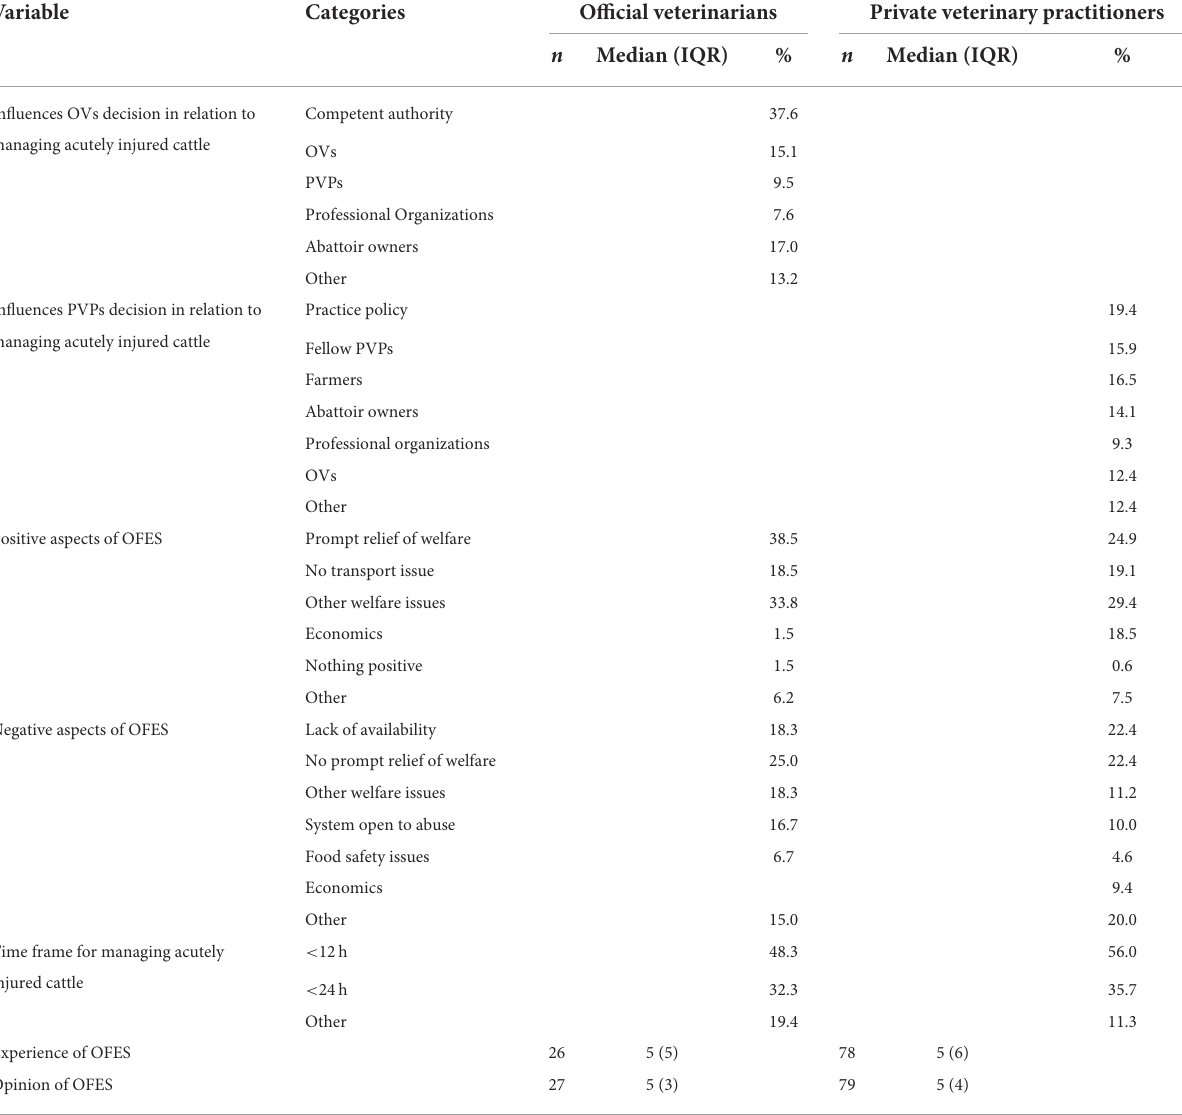
TABLE 3 Factors influencing the willingness of Official Veterinarians and Private Veterinary Practitioner regarding the use of on-farm emergency slaughter for the management of acutely injured cattle in Ireland.